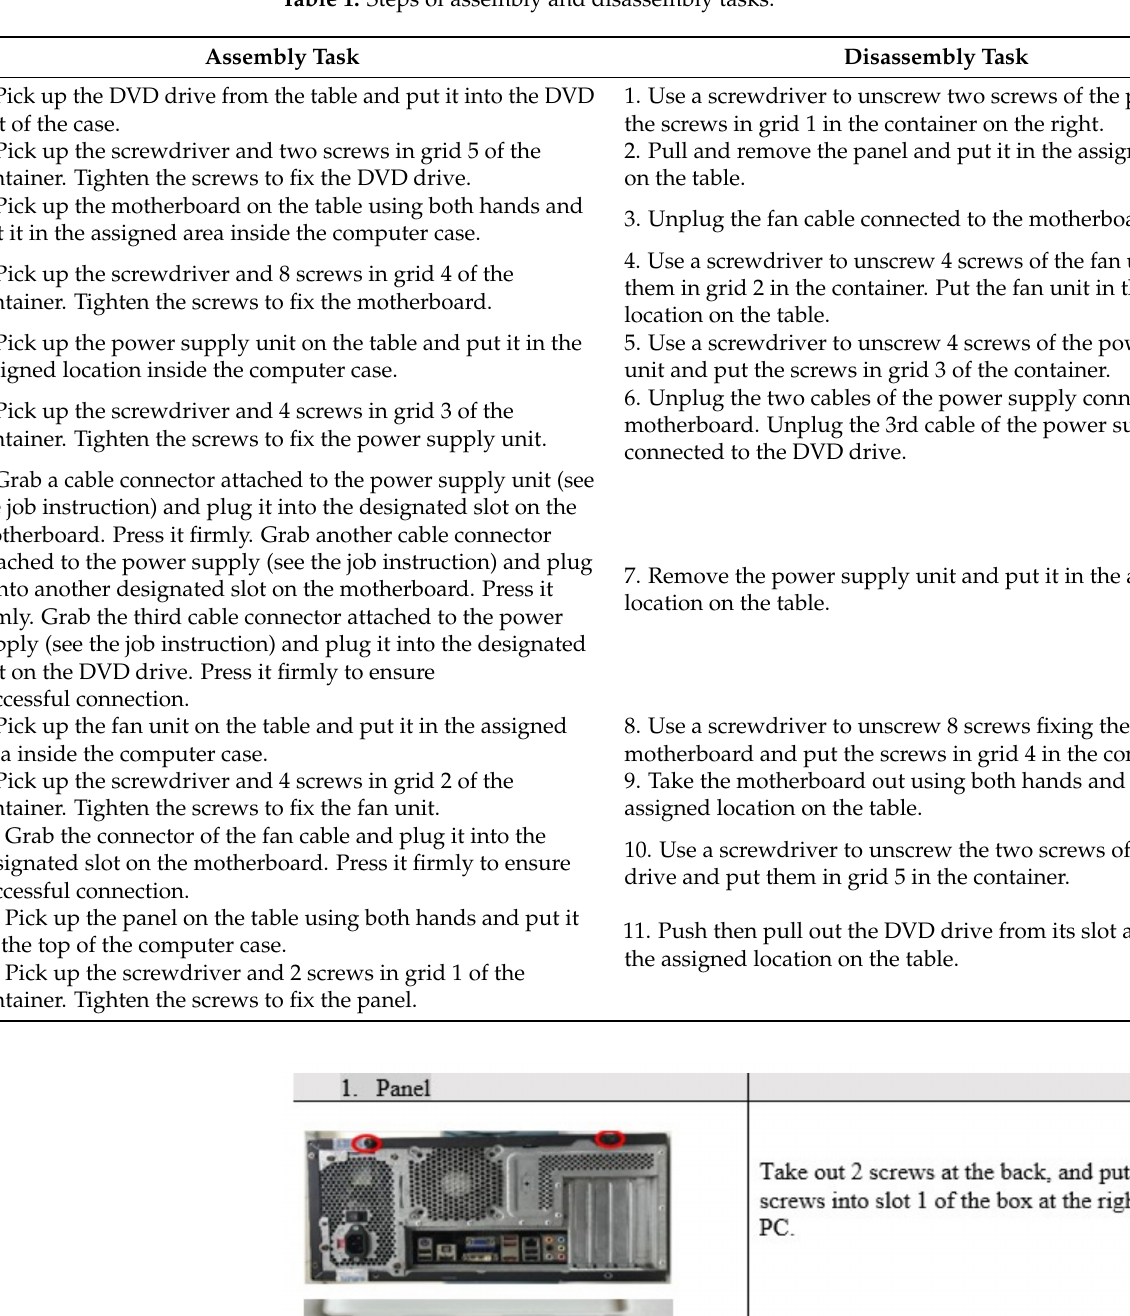
Table 1. Steps of assembly and disassembly tasks.